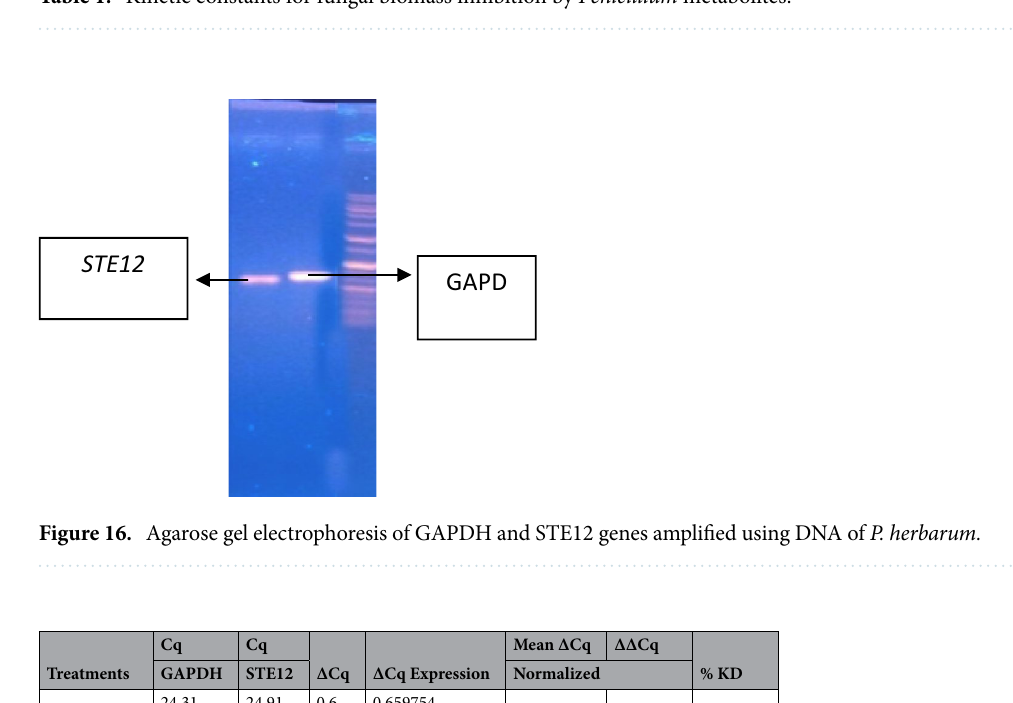
Table 1. Kinetic constants for fungal biomass inhibition by Penicillium metabolites.